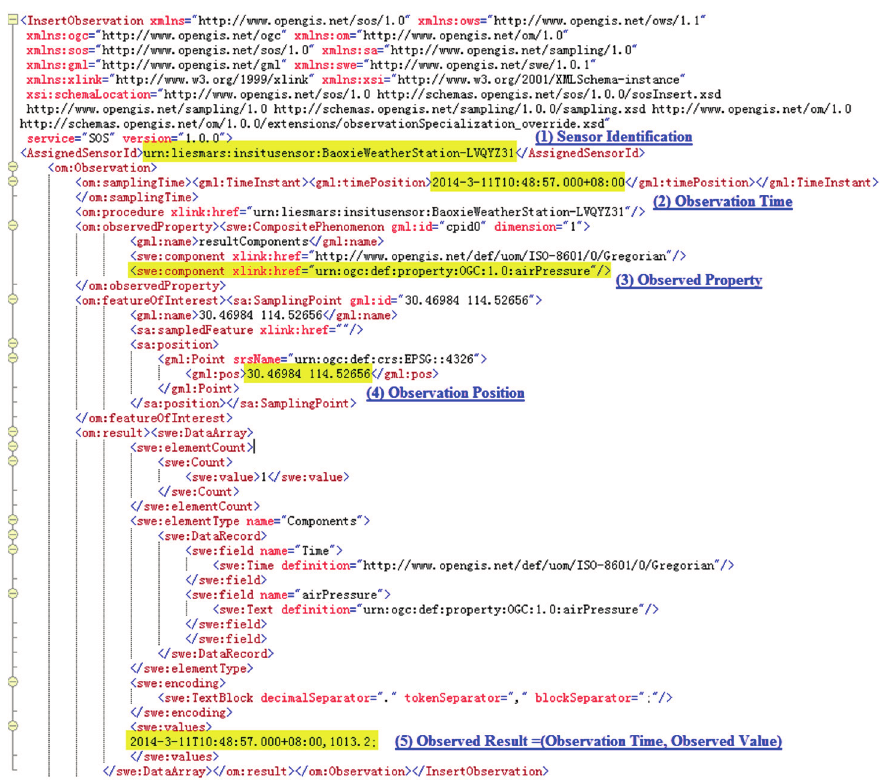
Figure 7. InsertObservation request for the LYQYZ31